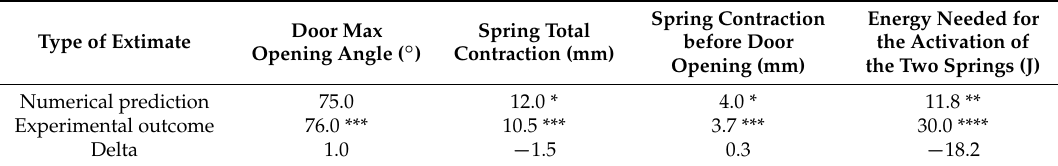
Table 4. Numerical predictions vs experimental outcomes.